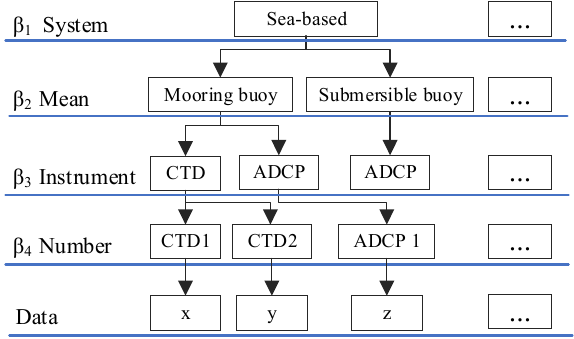
Figure 2. Data source hierarchy